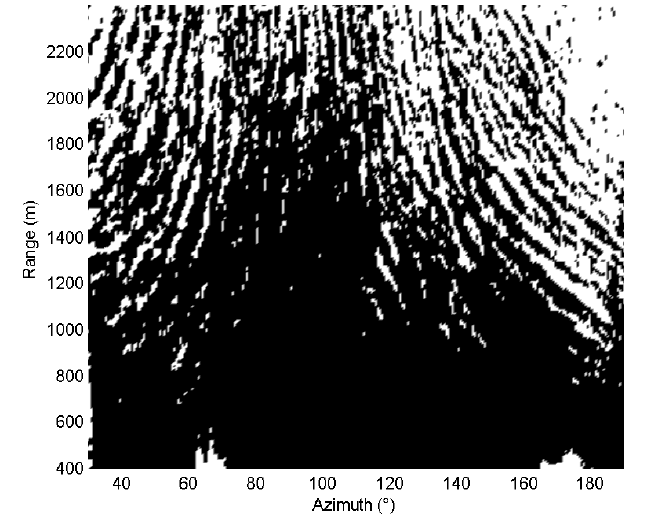
Figure 9. The shadow image after thresholding.